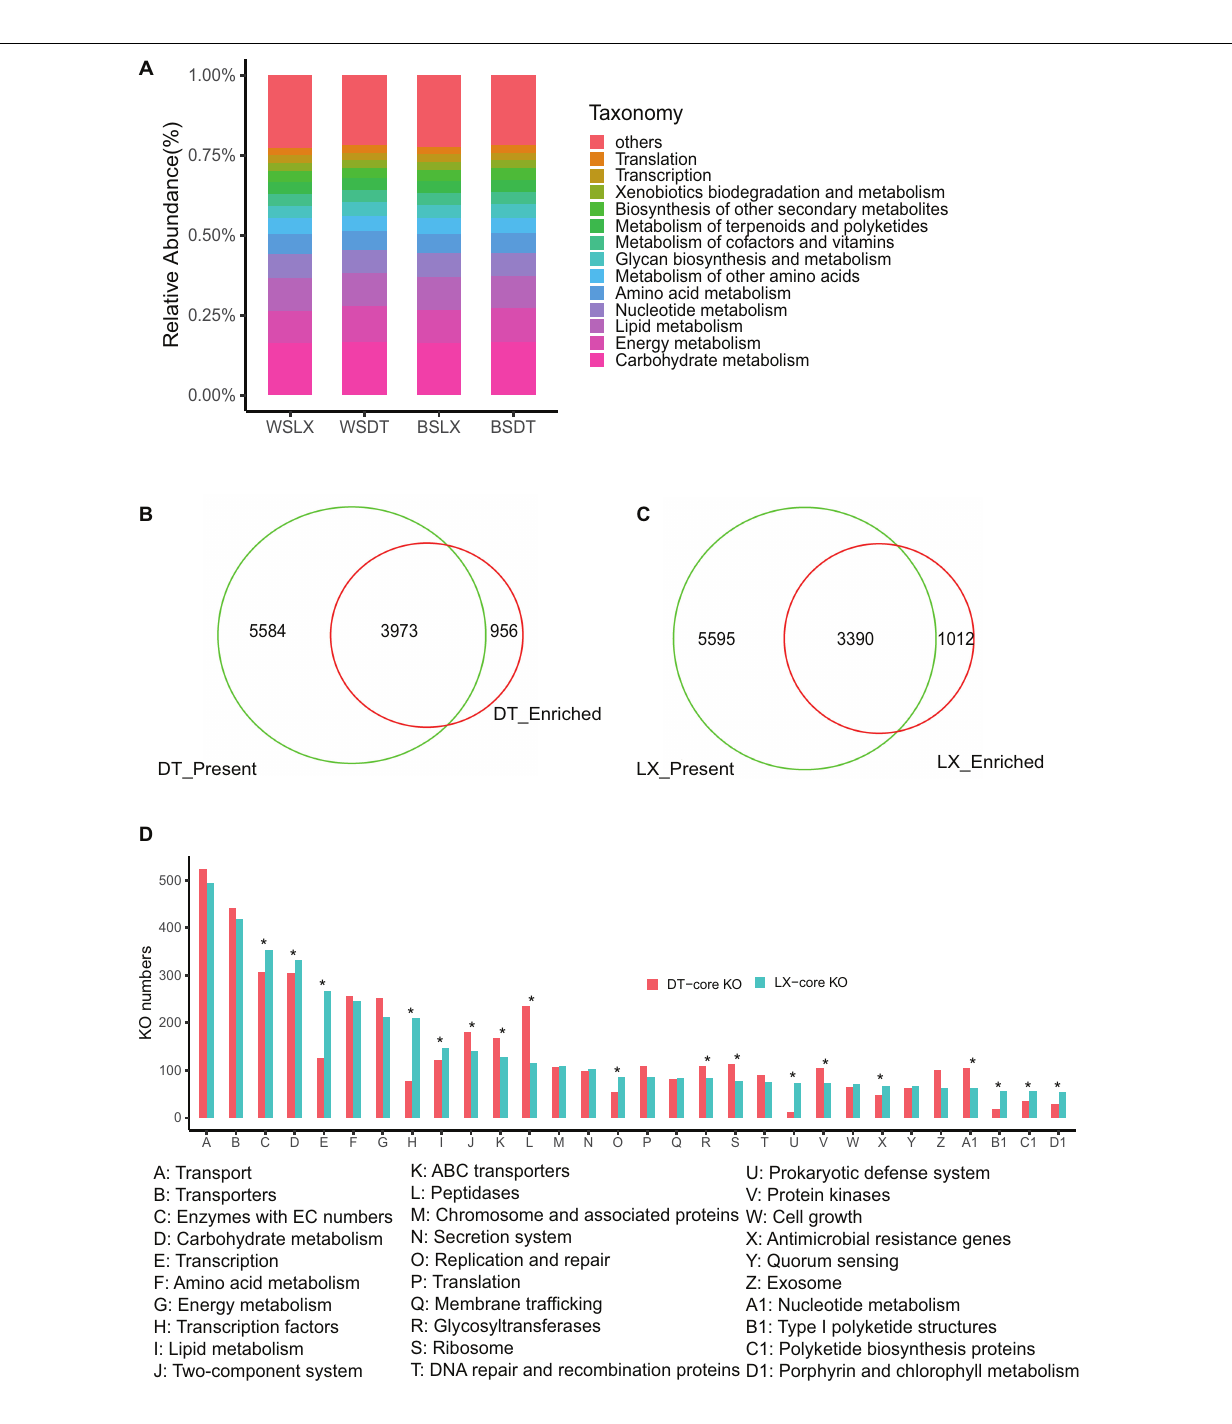
Frontiers in Microbiology |